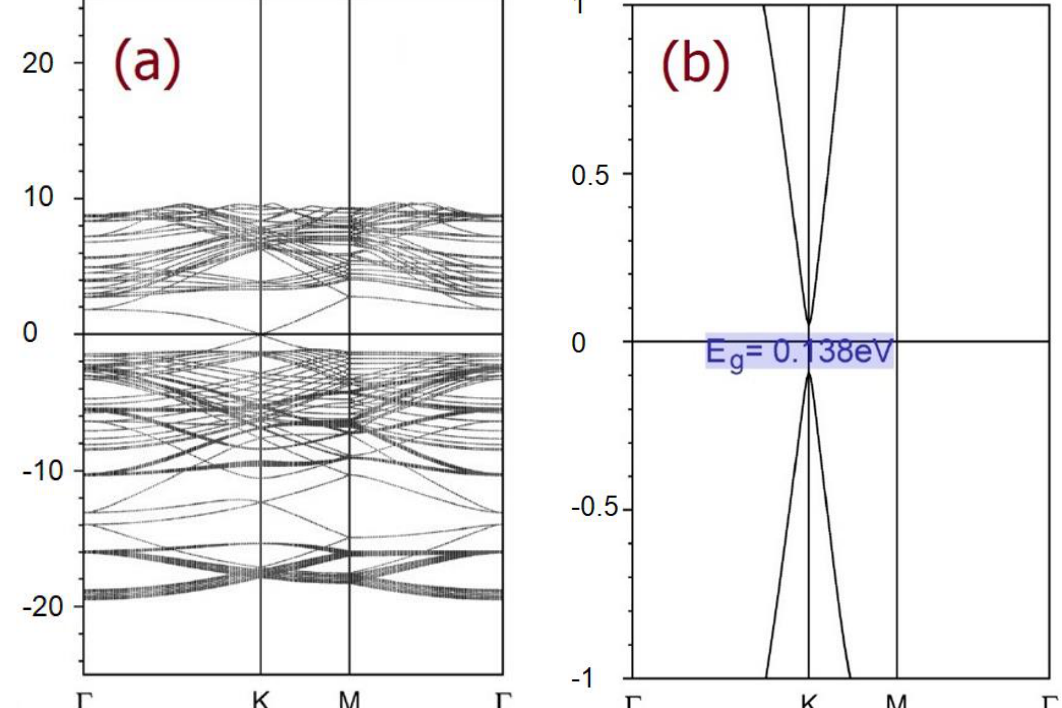
Figure 5. ( a ) Bands of the interface 2 × 2-graphene/2 × 2-(0001) BN (A-lattice) and ( b ) zoom around of K point.